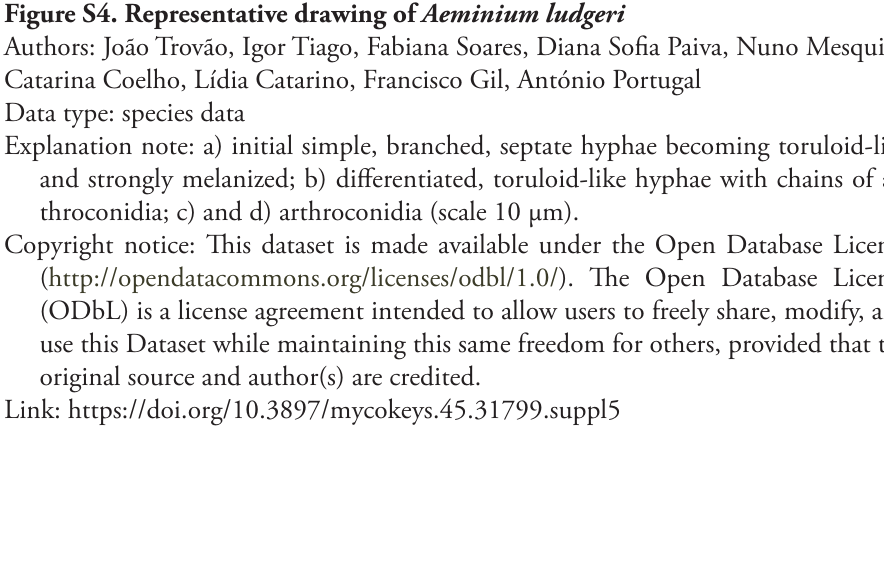
Figure S4. Representative drawing of Aeminium